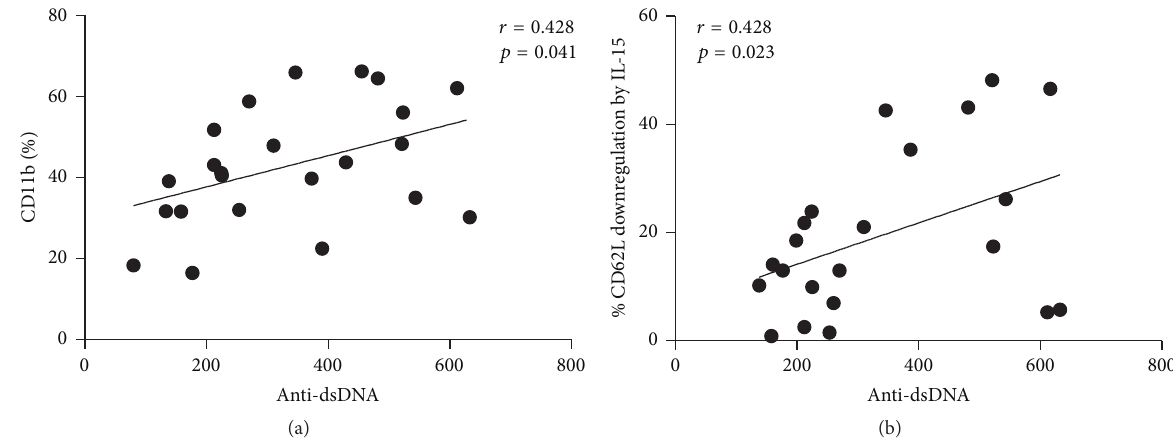
Figure5:Correlationbetween(a)serumanti-dsDNAandthepercentagesofCD11b + NKcellsand(b)serumanti-dsDNAandthe%inhibition of CD62L MFI on NKT-like cells by IL-15 calculated as [MFI of CD62L in medium − MFI of CD62L in the presence of IL-15 (10ng/mL) for 18 hours/MFI of CD62L in medium] ×